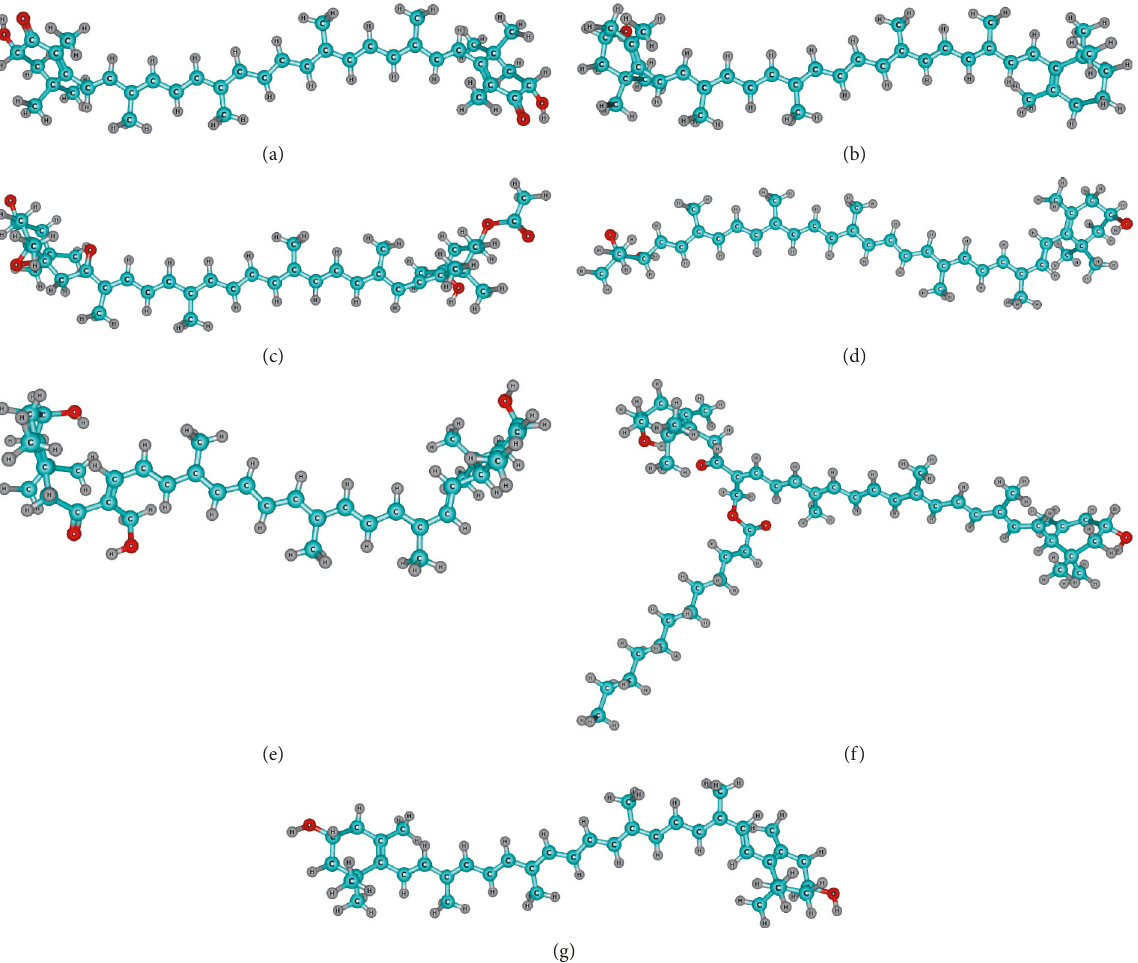
Figure 1: Graphical sketches of the molecular structures of the carotenoid pigments of marine origin: (a) astaxanthin; (b) β -cryptoxanthin; (c) fucoxanthin; (d) myxol; (e) siphonaxanthin; (f) siphonein; (g)